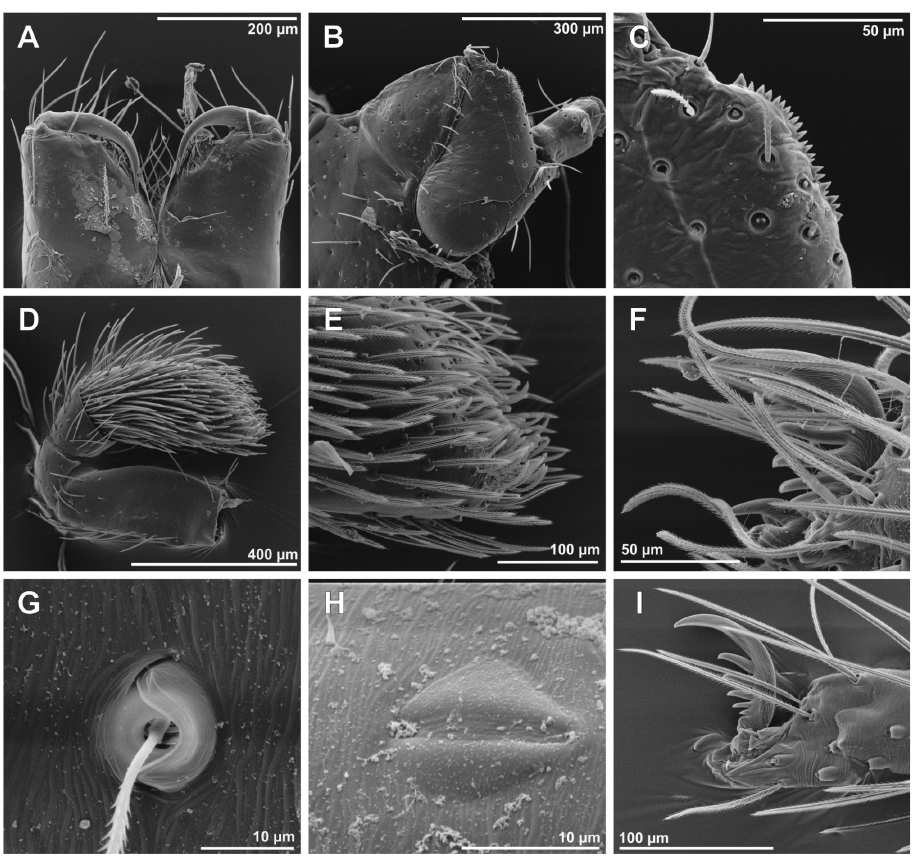
Figure 7. SEM images of Taintnops paposo sp. n., female paratype ( A–I ) A chelicerae, ventral view B left endite and labium, ventral view C left serrula, ventral view D left pedipalp , prolateral view E same, distal area, prolateral view F paired claws on right leg I, prolateral view G trichobotria base on leg II, dorsal view H sensilla on leg II, dorsal view I paired claws on right leg IV, prolateral